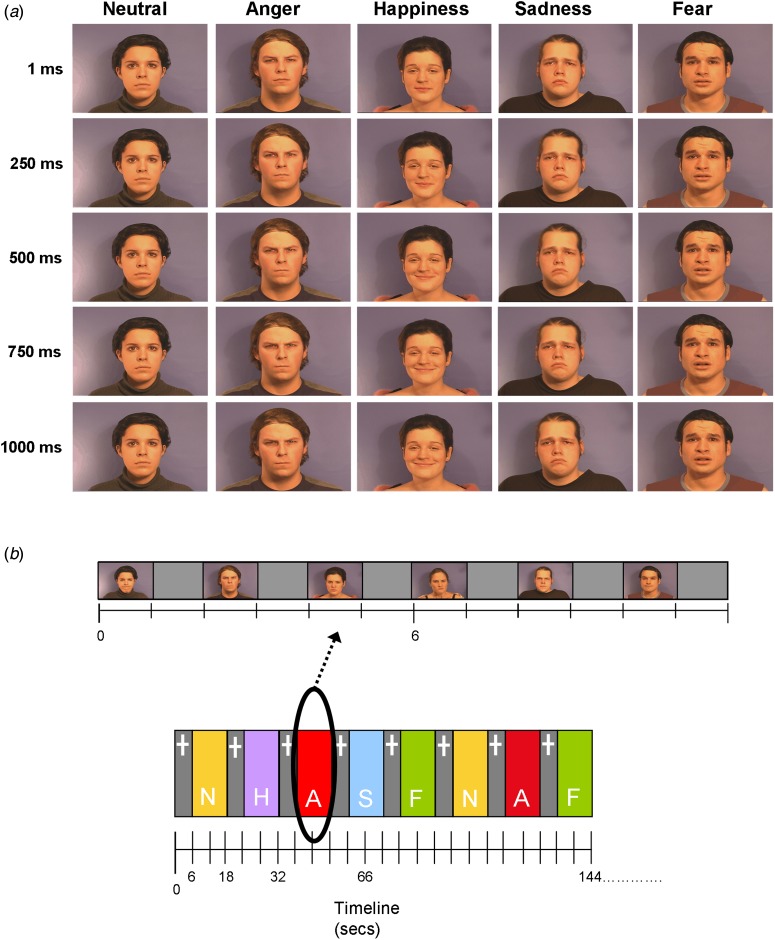
(a) Examples of actors expressing the five emotions: neutral, anger, happiness, sadness and fear. Five time points in the clip (1, 250, 500, 750, 1000 ms) are displayed. (b) Showing (top row) an example emotion block (angry) and (bottom row) the block structure of the task comprising 6-s fixation cross blocks (+) interspersed with 12-s emotion blocks (A, angry; F, fear; H, happy; N, neutral; S, sad).